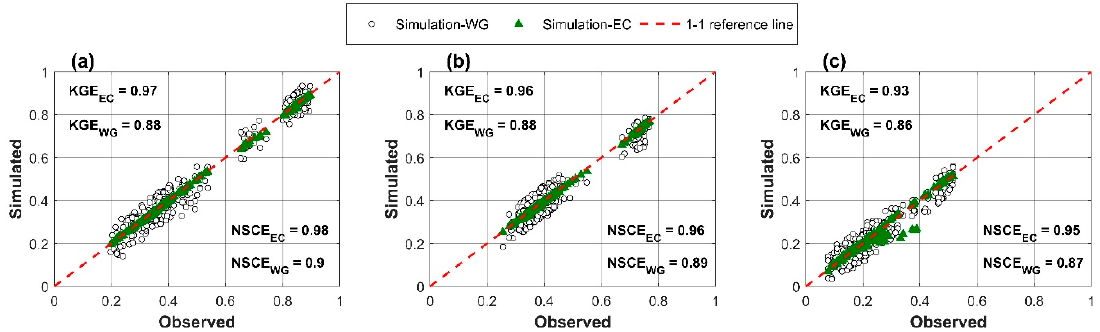
Figure 11. Performance evaluation for empirical copula (EC) and weather generator (WG) models for preserving the spatial and cross correlations of the weather variables for each month.